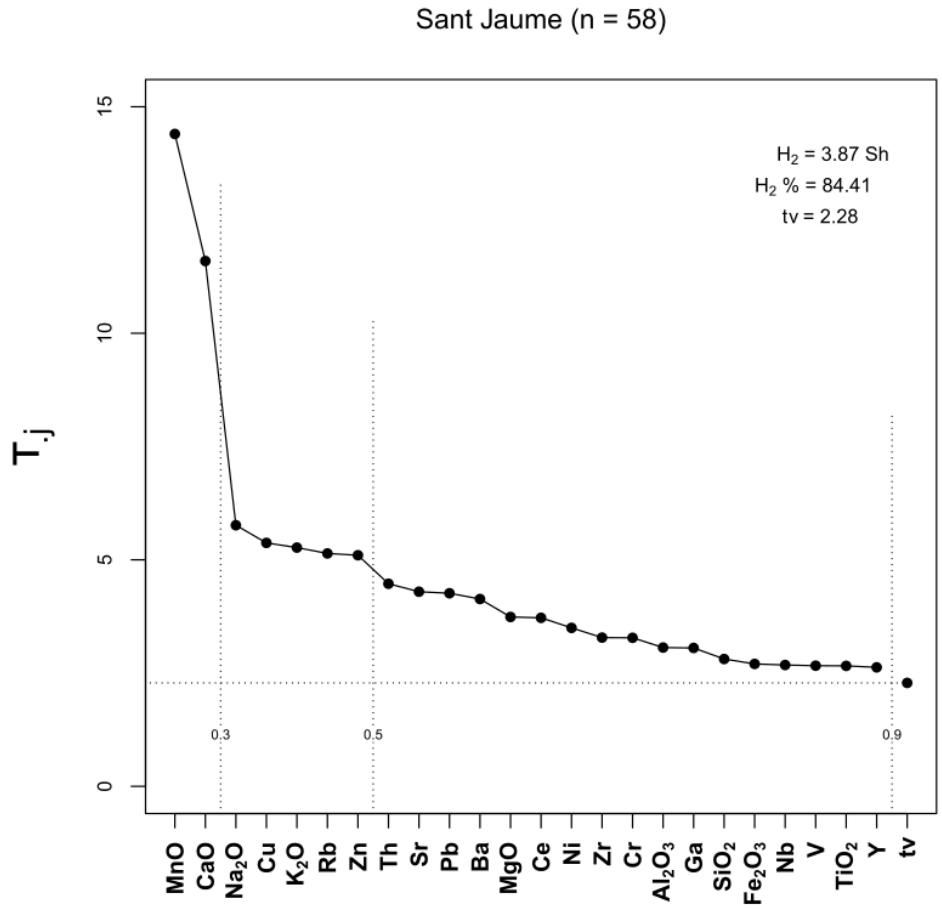
Figure 4. Compositional evenness graph of the 58 studied individuals. H 2 : information entropy (in Shanons, Sh); H 2 %: percentage of the maximum possible attainable; tv: total variation. τ . j : trace of the variance-covariance matrix following the alr transformation using element j as the divisor. Vertical dotted lines express different tv/ τ . j values. Table 2. Chemical concentrations by WD-XRF. Major and minor elements expressed as oxides are